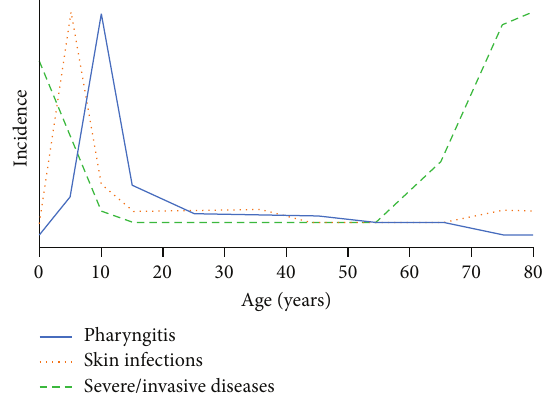
Figure 1: Schematic representation of incidence of group A strep- tococcal diseases by age using data from epidemiological reports [27, 30–33].